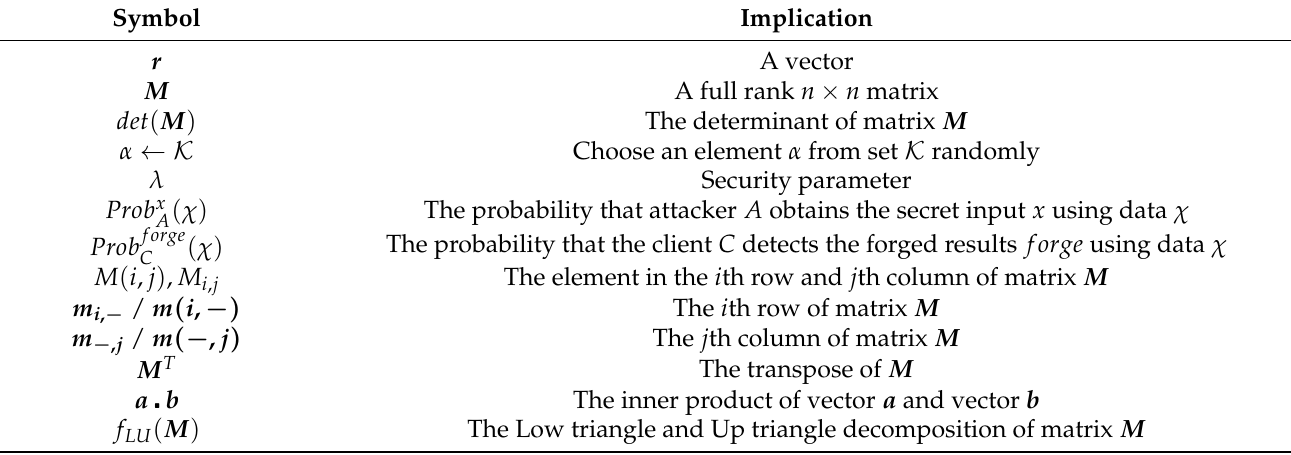
Table 2. Symbols and